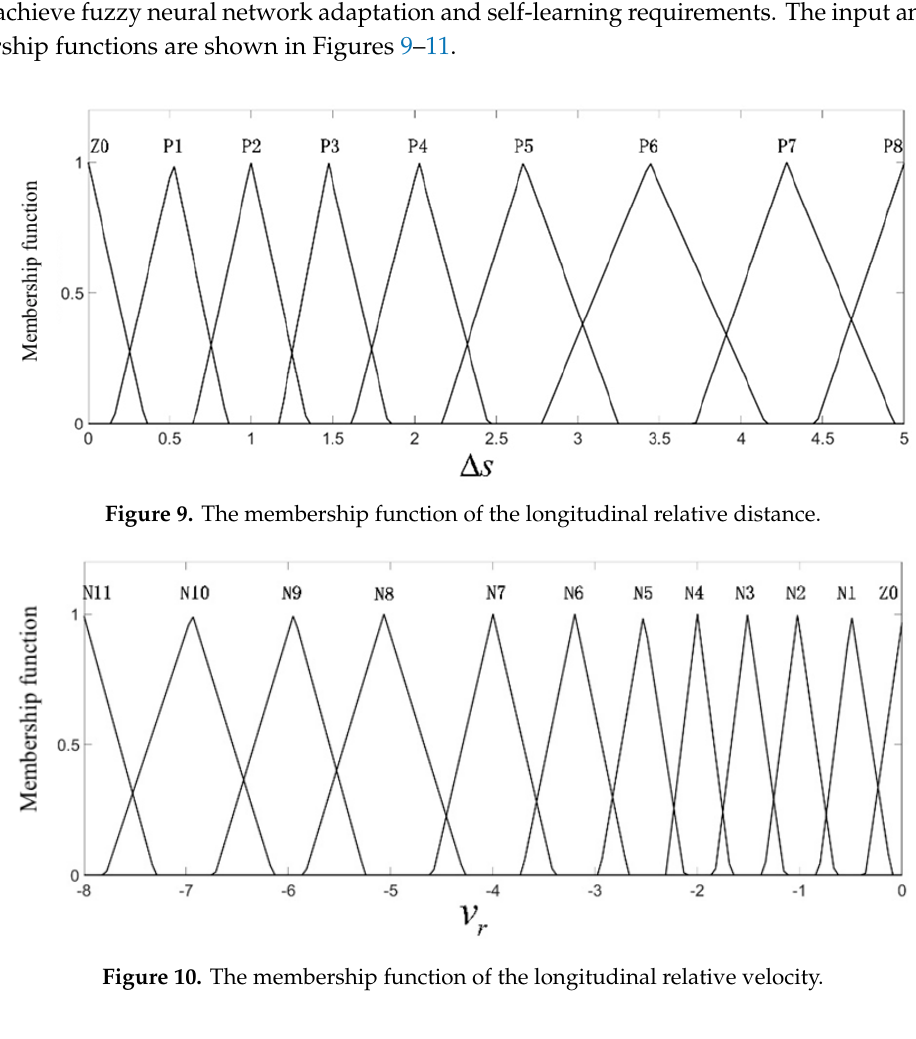
Figure 11. The membership function of the expected deceleration. In Figure 9, the relative vertical distance